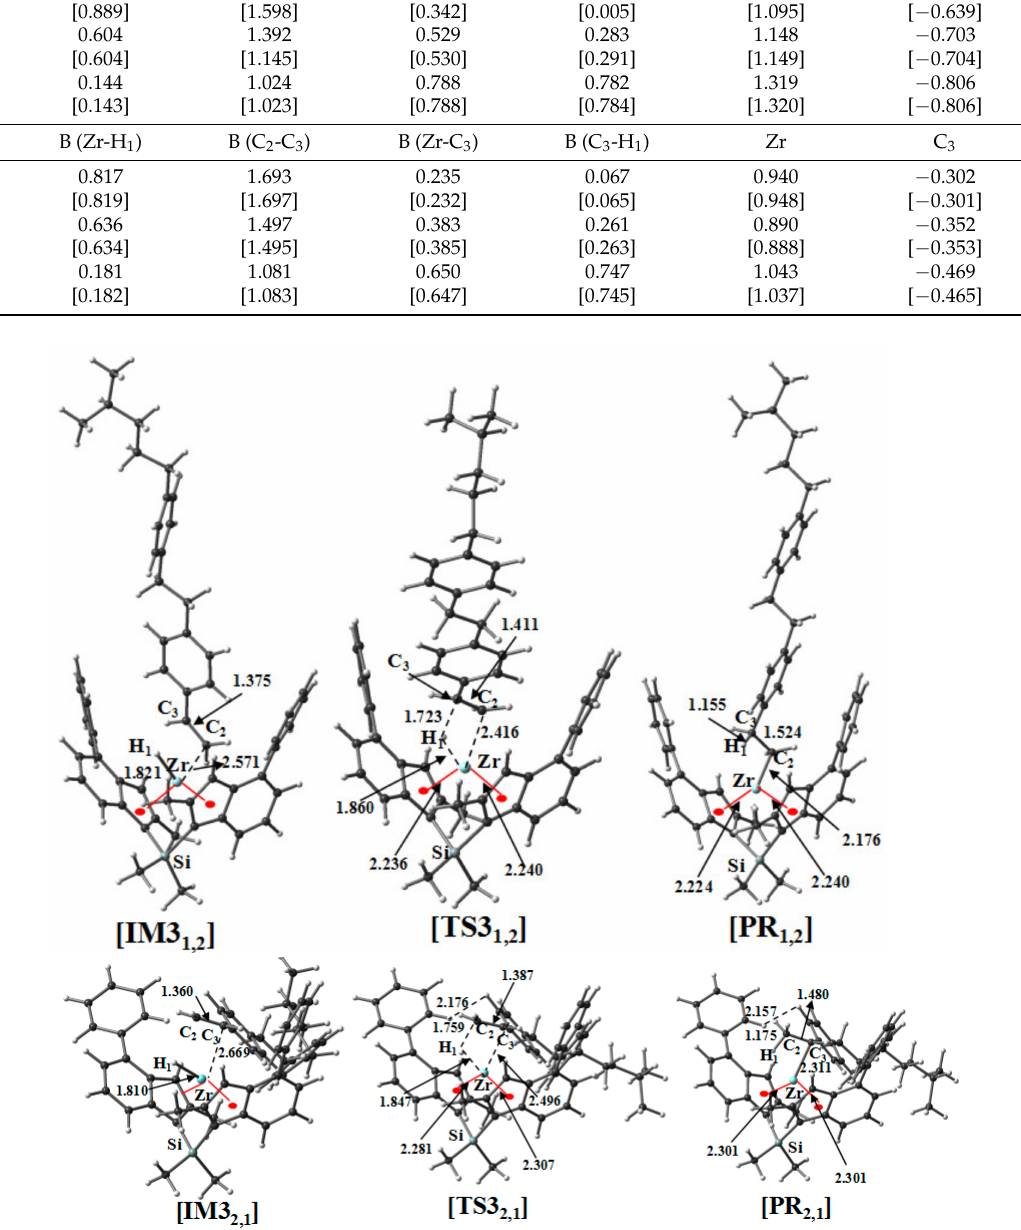
Figure 7. Optimized structures of key TSs and intermediates (IMs) in the BVPE reaction pathway shown in Figure 5. The key length is in angstroms.